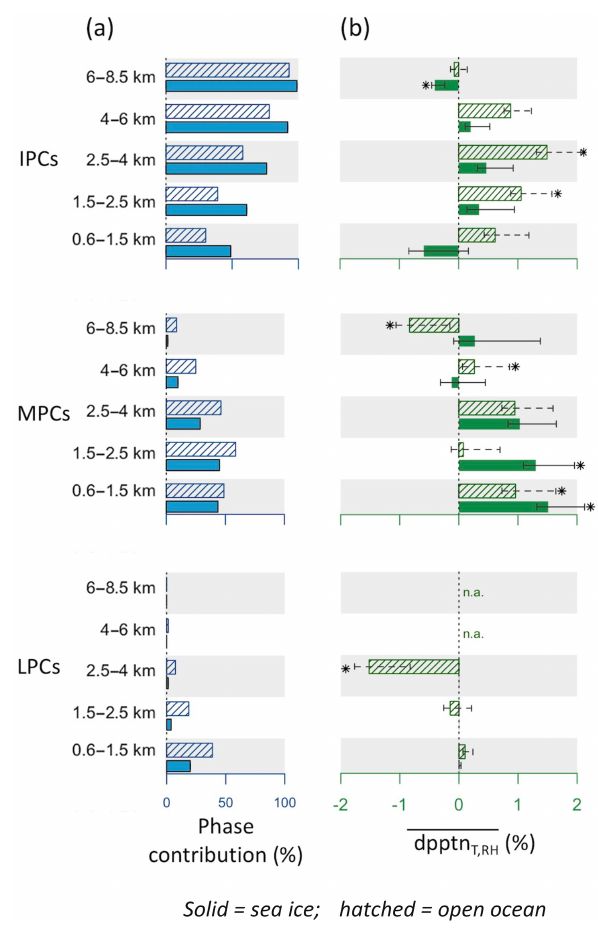
Figure 5. The absolute changes in (a) CP distribution (blue) and (b) d pptn T, RH (green) for IPCs, MPCs, and LPCs over sea ice (solid) and open ocean (hatched) at different altitude ranges. An asterisk (*) indicates that the differences between all and clean con- ditions were significant for both relative and absolute values, based on a paired Wilcoxon rank test, p <0.05, using T –RH grid cells containing >800 (400 for d CP T, RH ) 12.5km 2 gridded observa- tions. Error bars show bootstrapped 95% confidence intervals for the weighted